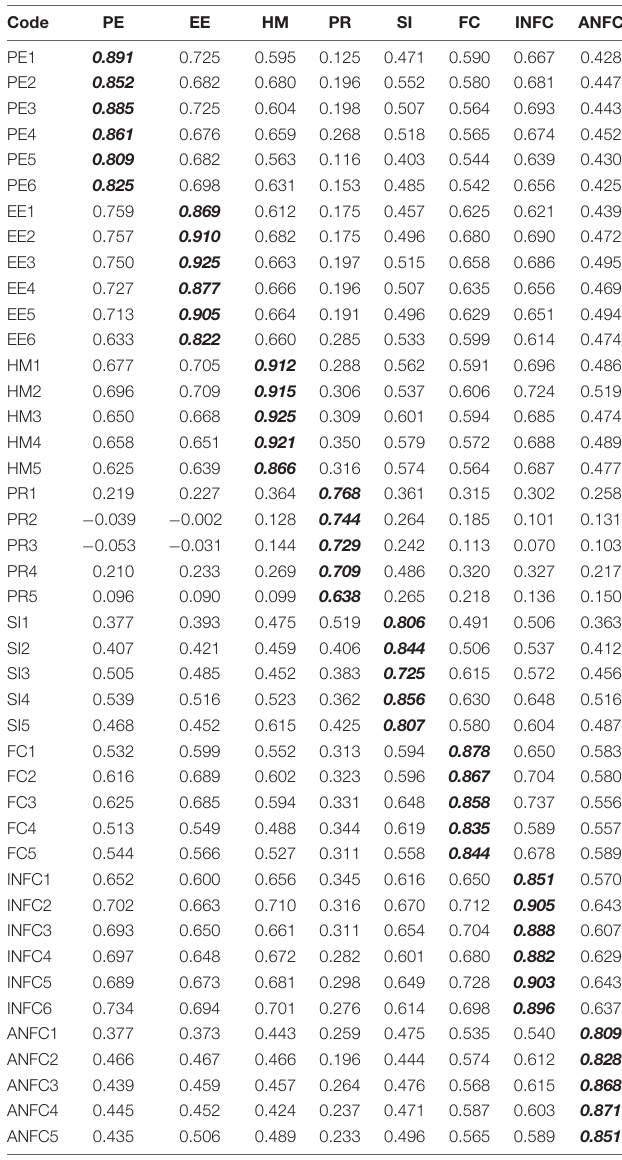
TABLE 4 | Loading and